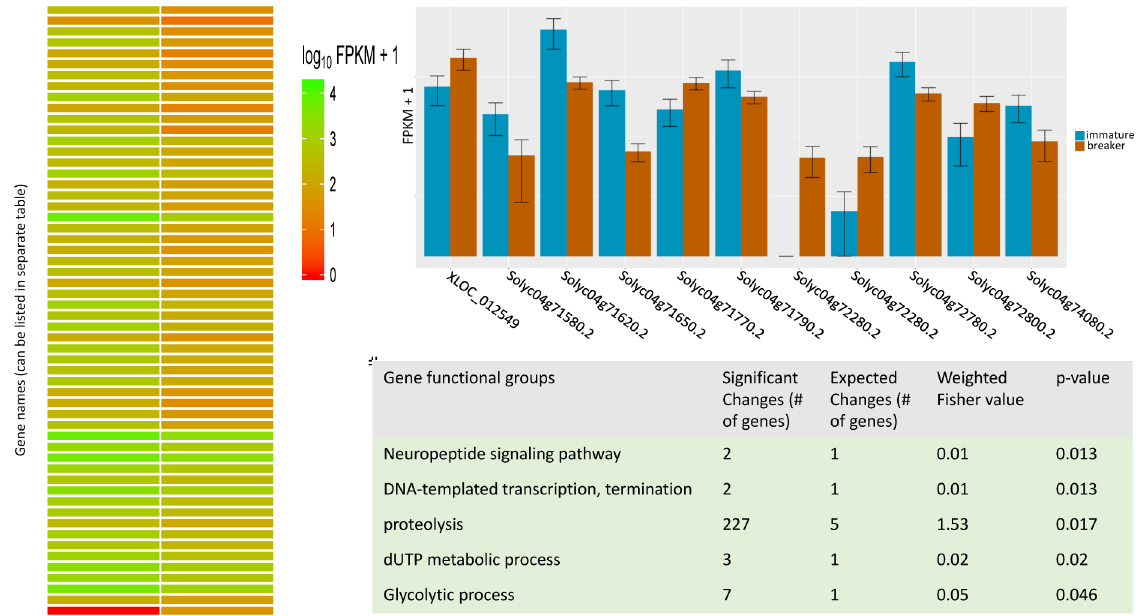
Fig 2. Sample figures and tables from RNAseq analysis in the described module. The RNAseq pipelinecreates a variety of figures that students can customize by changingthe R-script that creates them. CummeRbund analysiscreates the heatmap(left) and the bar chart (top right). Using the R-packageTopGO, students calculate the probabilities (using Fisher exact tests) that certain functionalcategories are enrichedin differentially expressedgenesfrom the RNAseqanalysis(table bottom right). Abbreviations: dUTP, 2´-Deoxyuridine, 5´-Triphosphate; FPKM, Fragments Per Kilobaseof transcript per Million mappedreads.